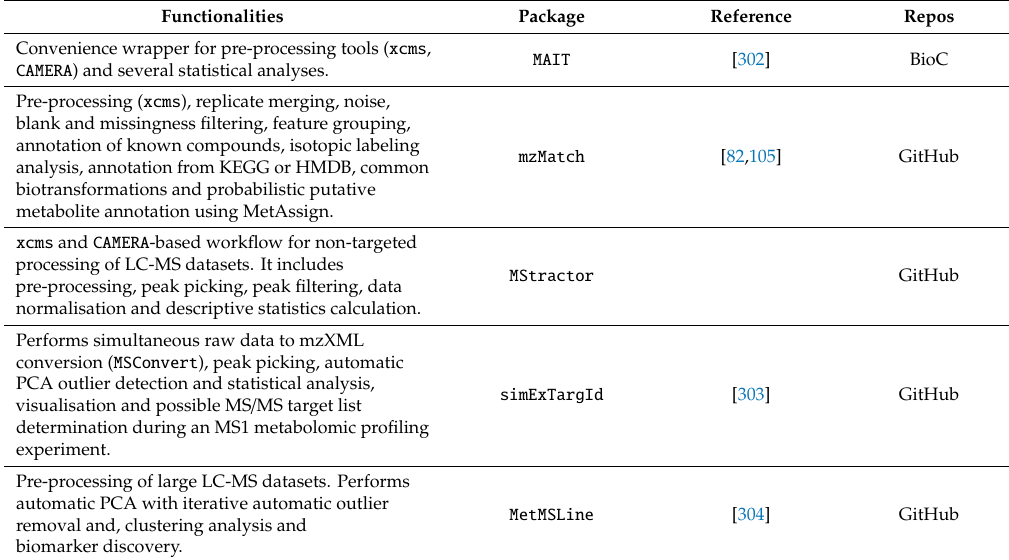
Table 9. R packages with multifunctional